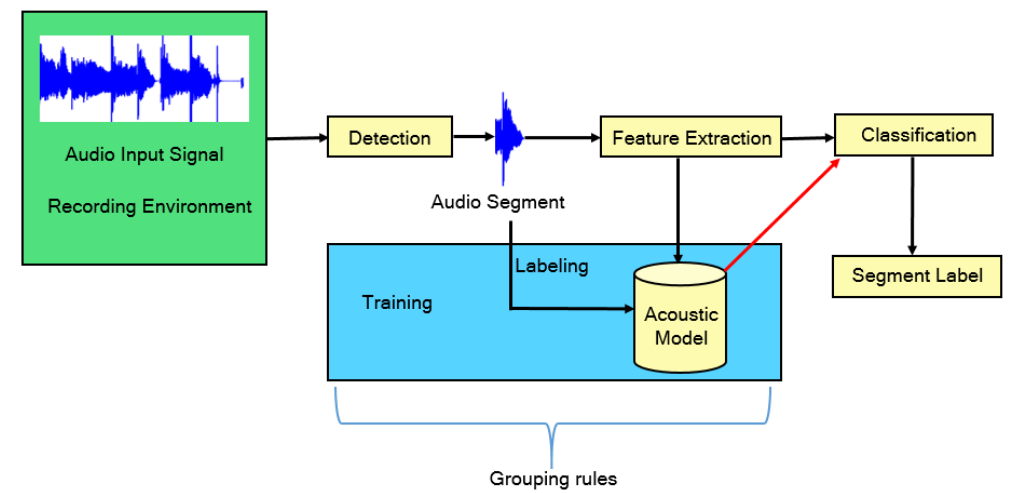
Figure 7. General audio event detection